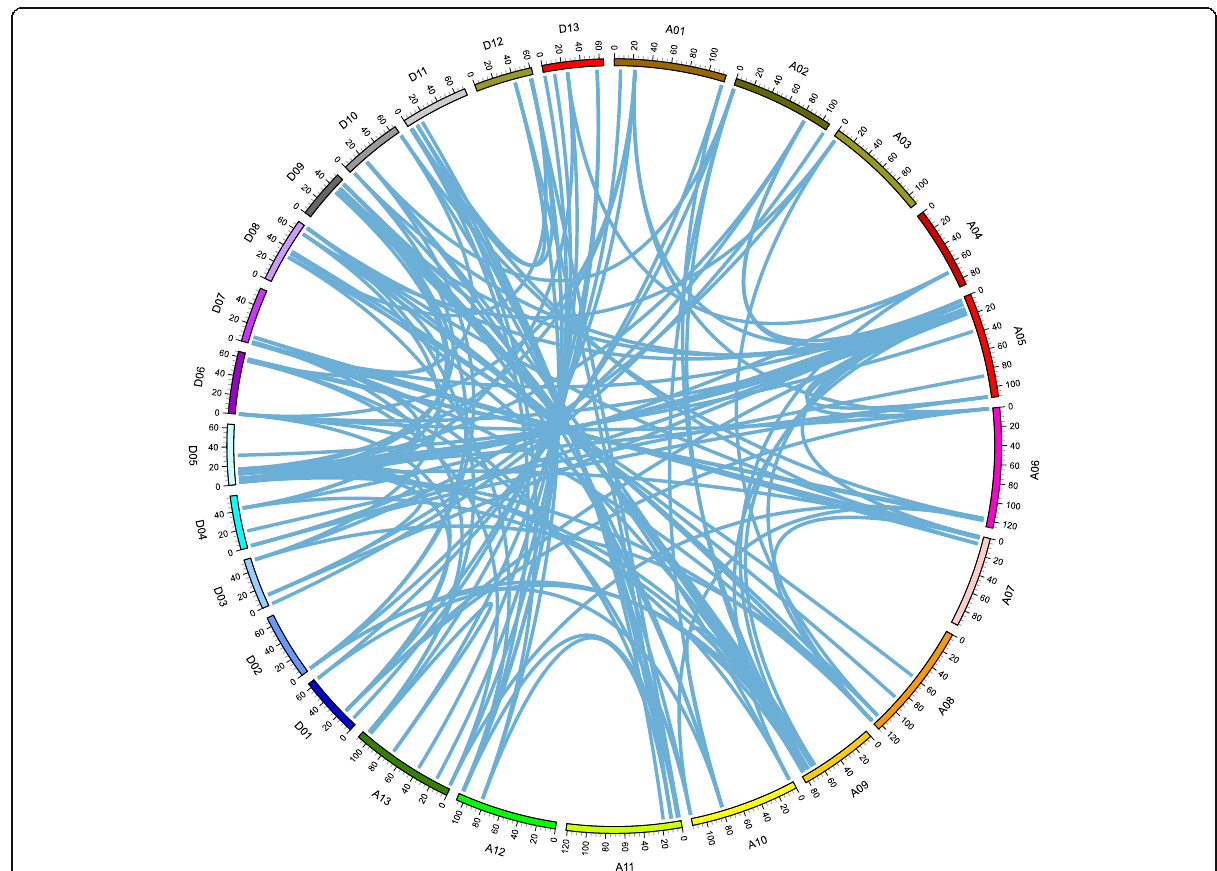
Fig. 3 Circos figure of GhIQD gene pairs that arose from segmental duplication. The G. hirsutum L. chromosomes from the A- and D-subgenomes are shown in different colors, and the gene pairs involved in segmental duplication are linked by blue lines. The CIRCOS genome visualization tool was used to construct this